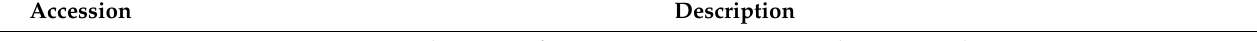
Table 4. Effects of feeding with matcha and decaffeinated matcha on the expression of proteins involved in antioxidative